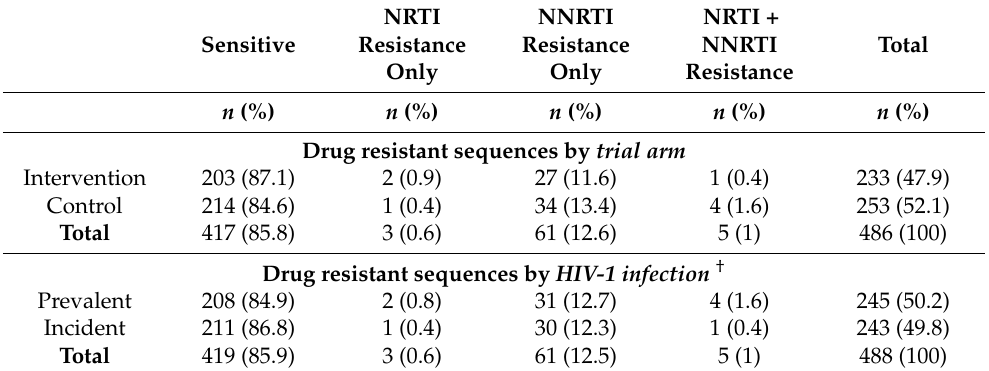
Table 4. Drug resistant sequences, by trial arm ( n = 486, NA = 2 *) and HIV-1 infection † ( n =